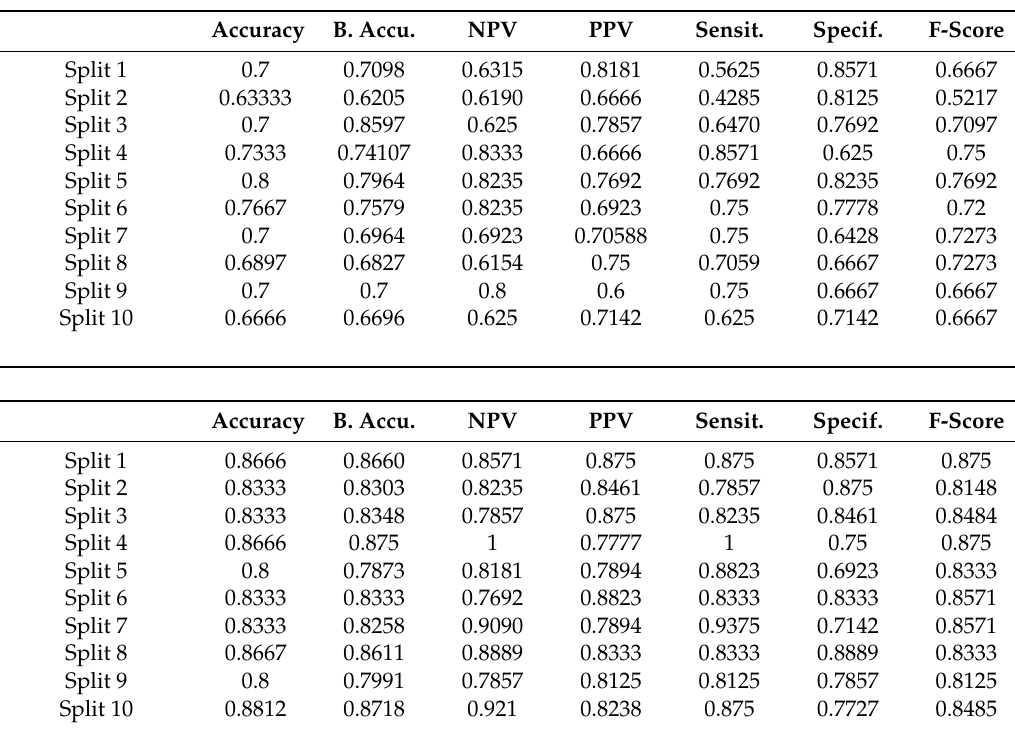
Table A4. Evaluation results showing a comparison between the evaluation metrics for each test split, using the Clinica baseline ( upper table ) and the proposed method (SVM trained using a linear kernel) for the reduced dataset ( lower table